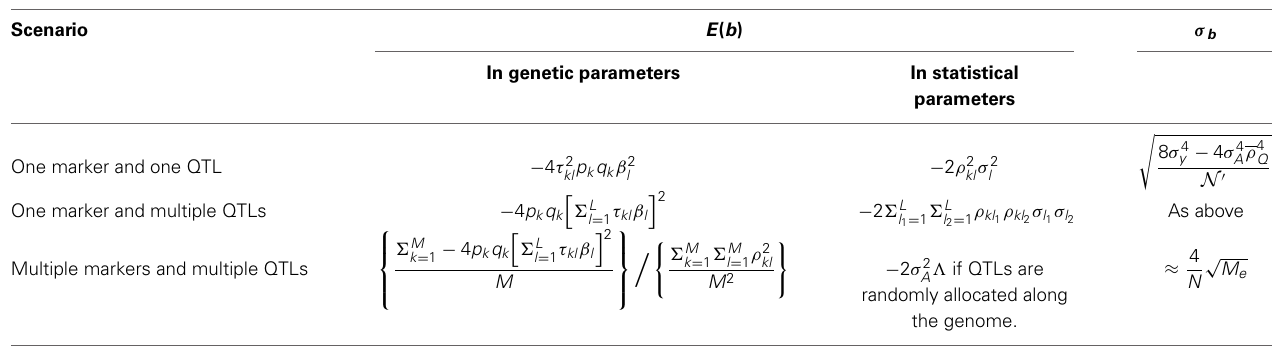
Table 6 | Summary of the derivations. Scenario